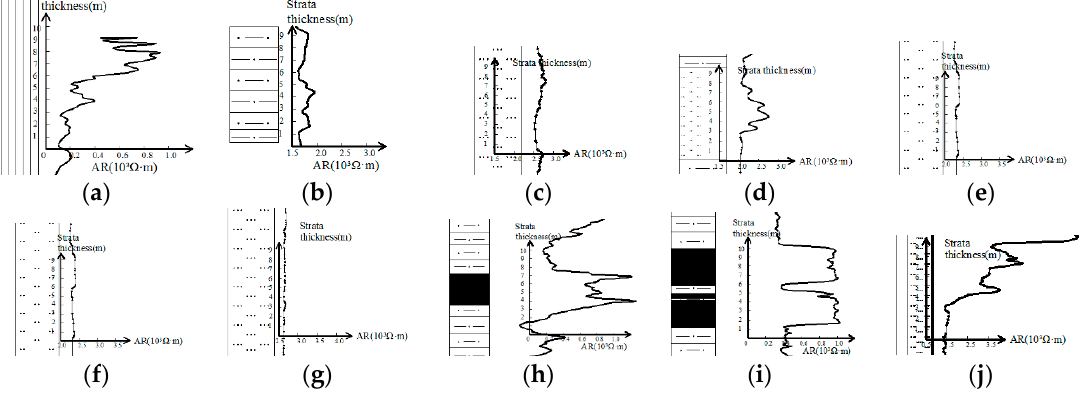
Figure 5. Characteristics of MT responses of common overlying strata: ( a ) quaternary loose layer; ( b ) sandy mudstone; ( c ) fine-sandstone; ( d ) medium sandstone; ( e ) coarse sandstone; ( f ) mudstone; ( g ) siltstone; ( h ) coal seam; ( i ) coal-rock interbed; ( j ) conglomerate.